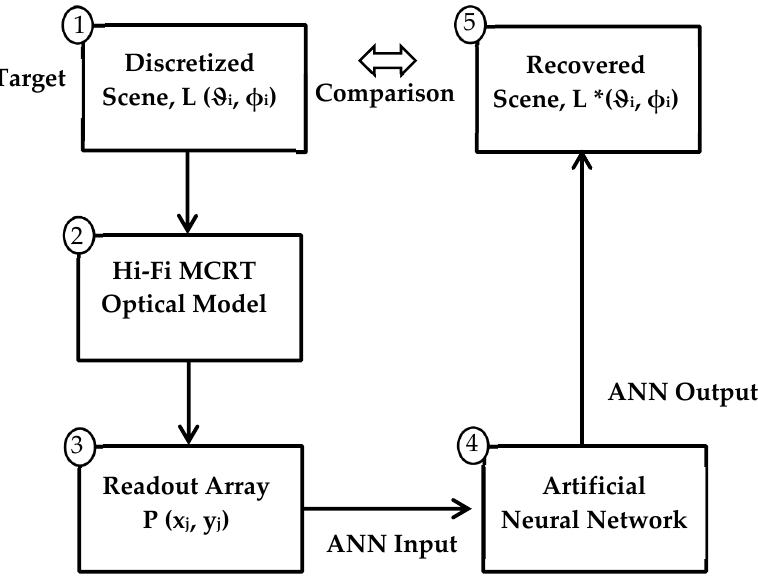
Figure 5. Numerical focusing logic block diagram.